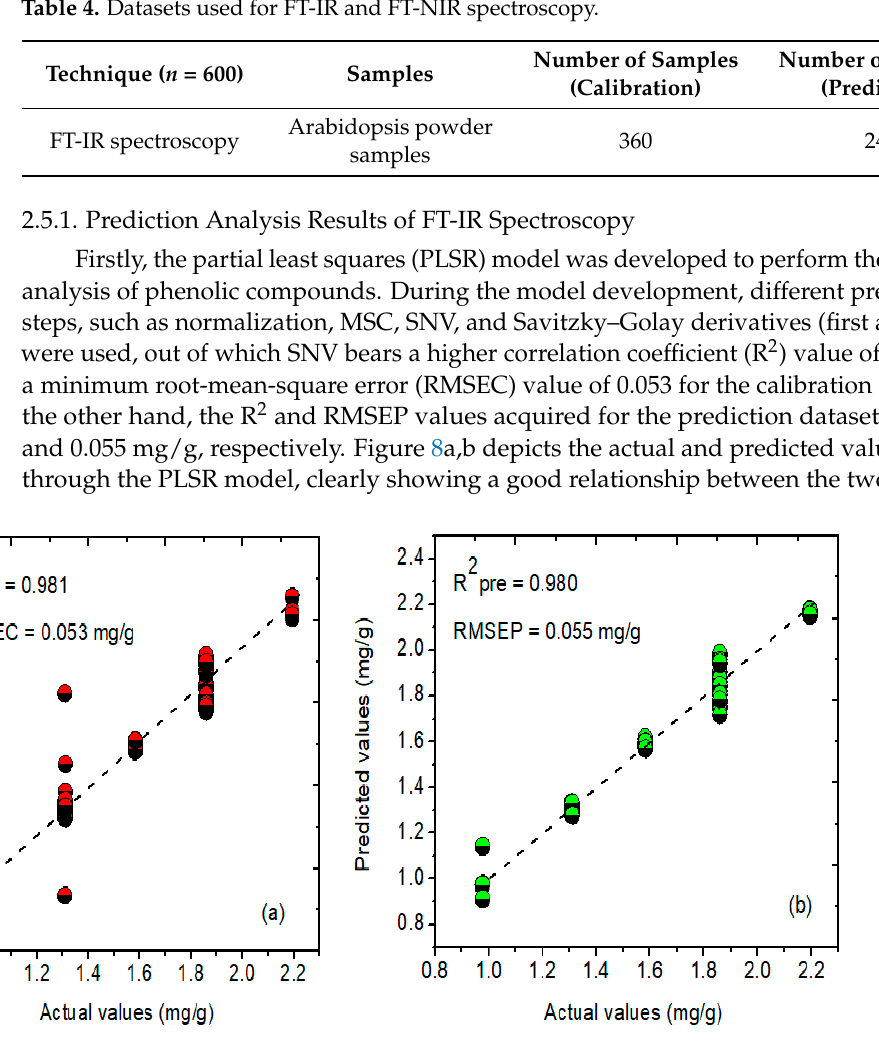
Figure 9 . PCR graphs of actual and predicted concentration values for the phenolic compounds in Arabidopsis powder samples using ( a ) calibration and ( b ) prediction datasets, respectively.